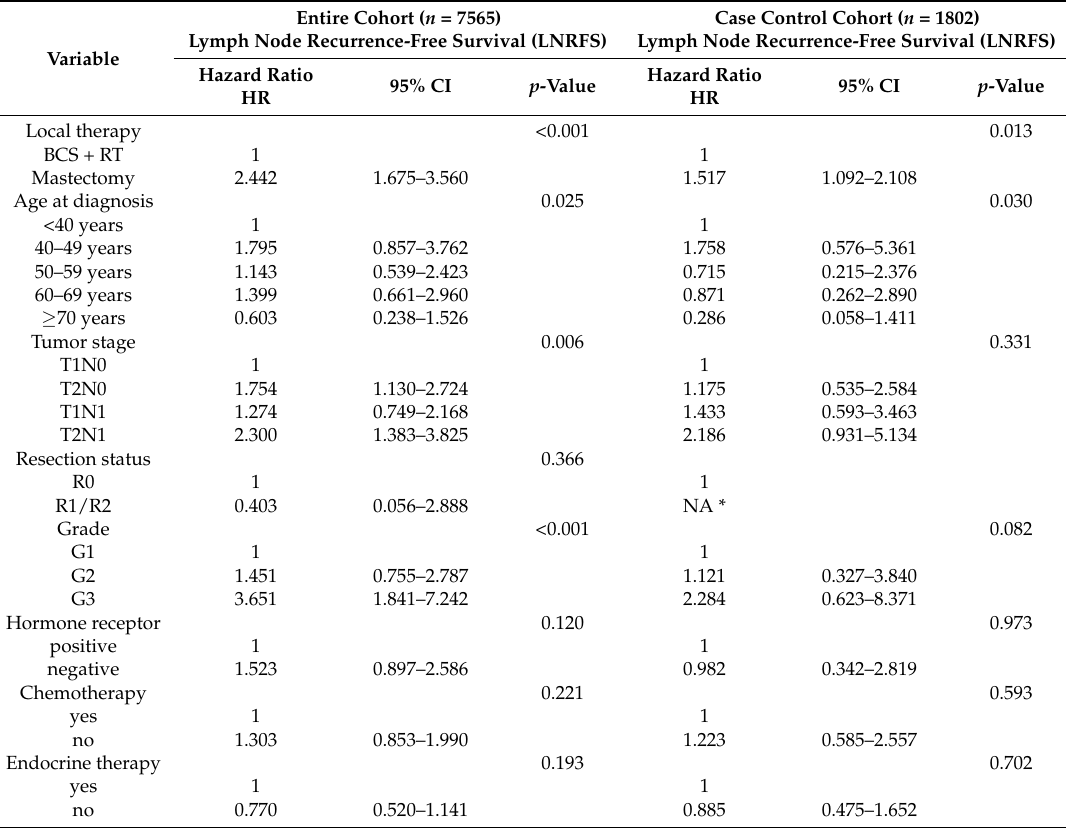
Table 4. Multivariable Cox regression analysis for lymph node recurrence-free survival (LNRFS).